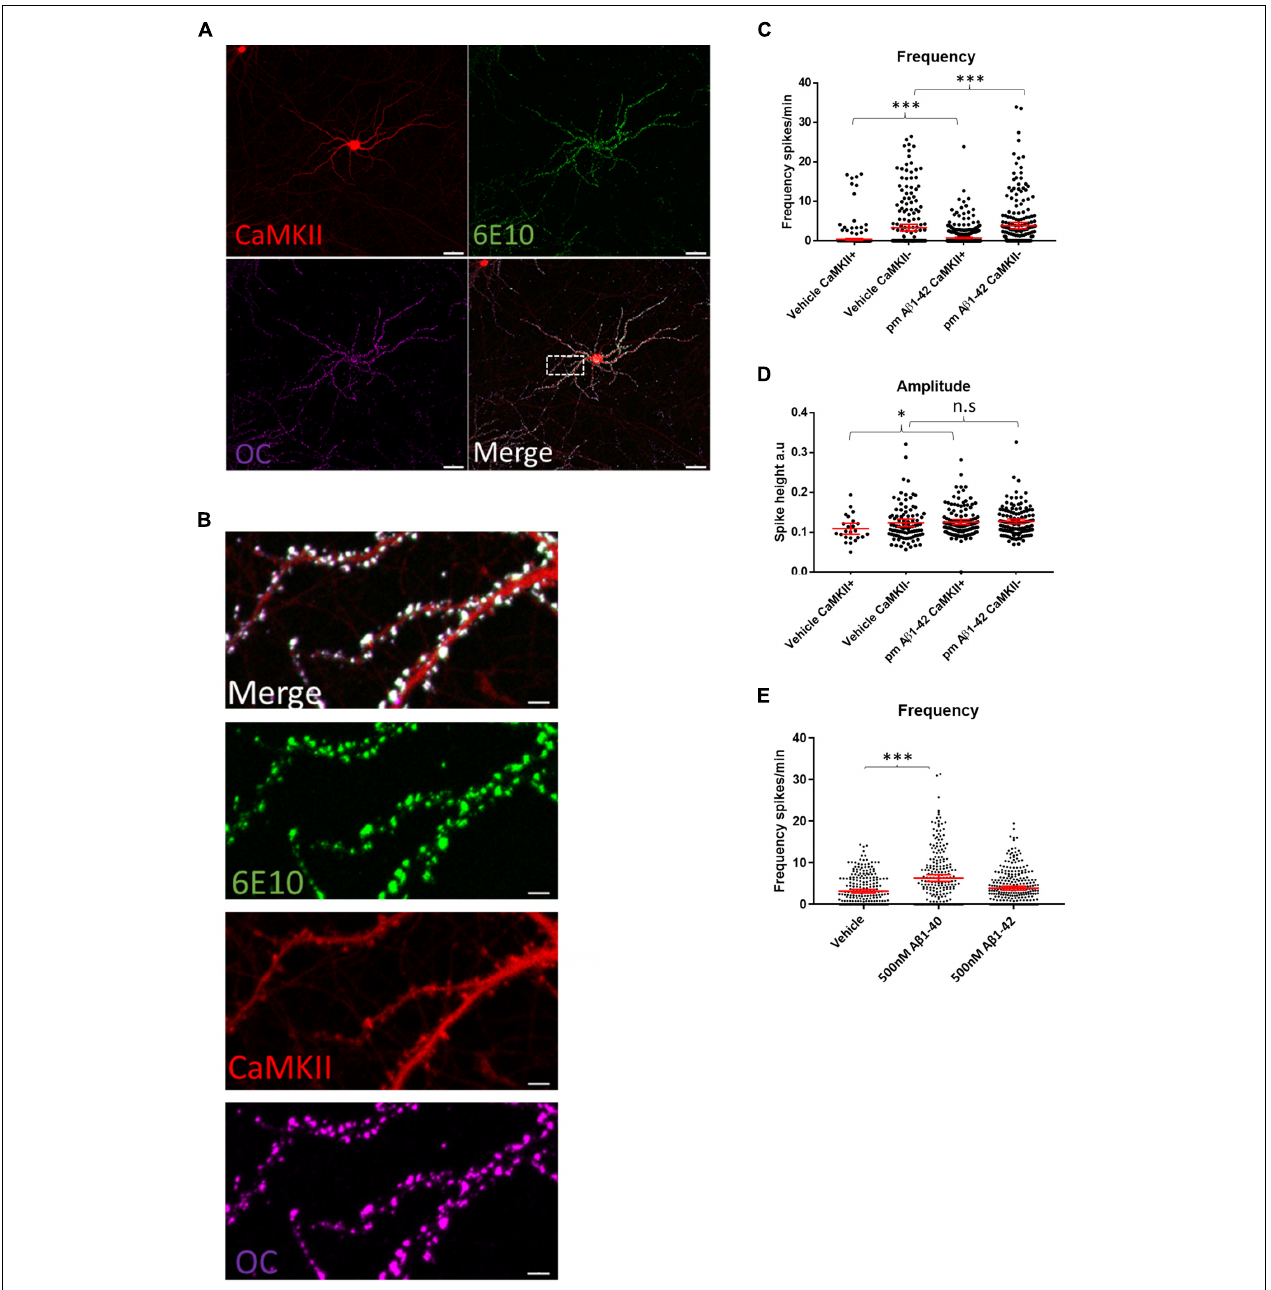
FIGURE 5 | A β preferentially binds synaptic compartments on CaMKII positive neurons and appears to have a dose dependent effect on spike frequency. (A) Micrograph showing that synthetic human A β 1–42 preferentially binds to dendrites of CaMKII positive murine WT neurons; Td Tomato expressed through CaMKII promoter, human specific anti-A β antibody 6E10 (green) and conformation specific anti-amyloid antibody OC (magenta); scale bar = 50 µ m. (B) Insert from (A) showing A β 1–42 targeting synapses; note that antibody 6E10 labels the added synthetic human A β and that this is also labeled by the fibrillar oligomer antibody OC; scale bar = 5 µ m. (C) WT neurons treated with 200 pM synthetic A β 1–42 show increased spike frequency compared to DMSO treated vehicle control neurons both in CaMKII positive neurons (A β 1–42 mean = 0.7554, CI = 0.5724–0.9383, n = 477, compared to vehicle mean = 0.367, CI = 0.1636–0.5704, n = 401, p < 0.0001) and in CaMKII negative neurons (A β 1–42 mean = 3.829, CI = 3.033–4.685, n = 214, compared to vehicle mean = 3.346, CI = 2.508–4.183, n = 218). (D) Graph depicting increased amplitudes in CaMKII positive neurons treated with 200 pM A β 1–42 compared with DMSO vehicle control (A β 1–42 mean = 0.1256, CI = 0.119–0.1321, n = 128, compared to vehicle mean = 0.1087, CI = 0.09495–0.1225, n = 24, p = 0.045). However, CaMKII negative neurons did not show a significant increase in amplitude with A β treatment (A β 1–42 mean = 0.1272, CI = 0.1209–0.1334, n = 133, compared to vehicle mean = 0.1235, CI = 0.114–0.133, n = 94, p = 0.2103). (E) Graph shows WT neurons treated with 500 nM A β 1–42 or 500 nM A β 1–40. While 500 nM A β 1–42 leads to a slight but not significantly different distribution of activity, A β 1–40 strongly increases activity (A β 1–40 mean = 6.344, CI = 5.503–7.186, n = 235 and A β 1–42 mean = 3.901, CI = 3.439–4.363, n = 287 compared to vehicle mean = 3.194, CI = 2.752–3.635, n = 255; p = 0.0001 and p = 0.14.); Kruskal–Wallis test, N = 3. n.s = not significant, * p < 0.05, *** p <